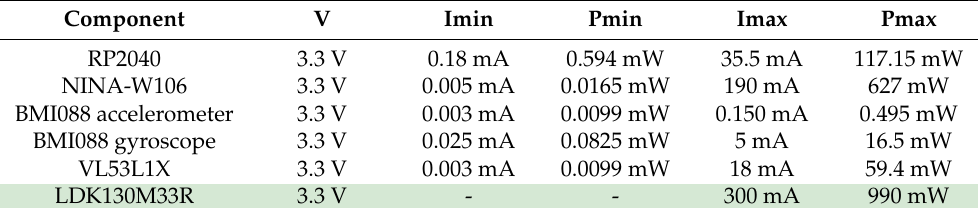
Table 6. Component consumption and power supplied by the LDK130M33R